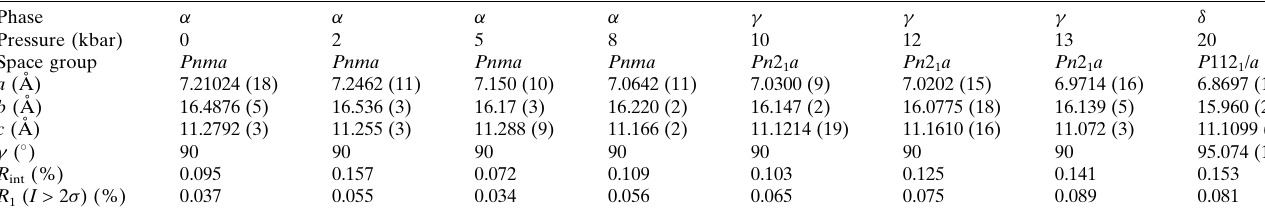
Table 3 Basic crystallographic data of the investigated 2 (cid:2) AP polymorphs. Phase